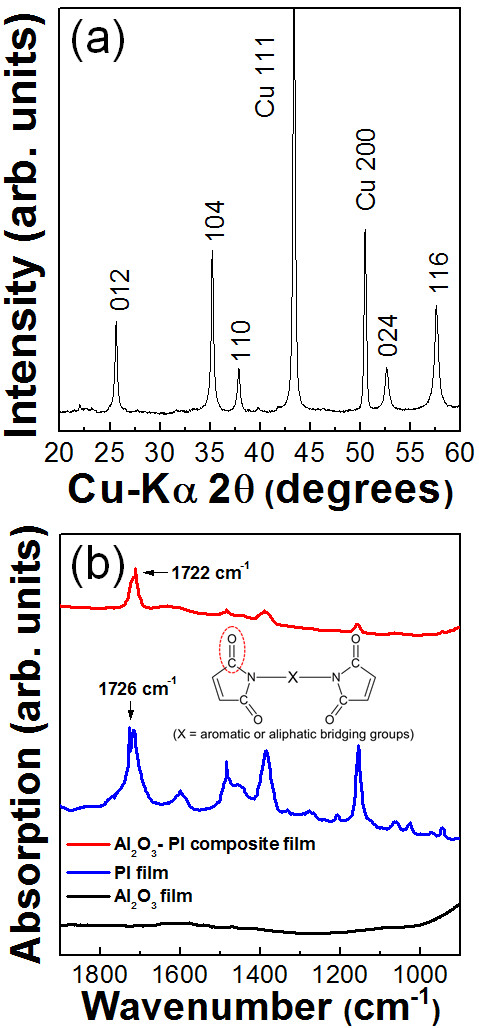
XRD patterns and FT-IR spectra. (a) XRD patterns of the Al2O3-PI (15 vol.%) composite films. (b) FT-IR spectra of the Al2O3-PI (15 vol.%) composite, PI, and Al2O3 films.